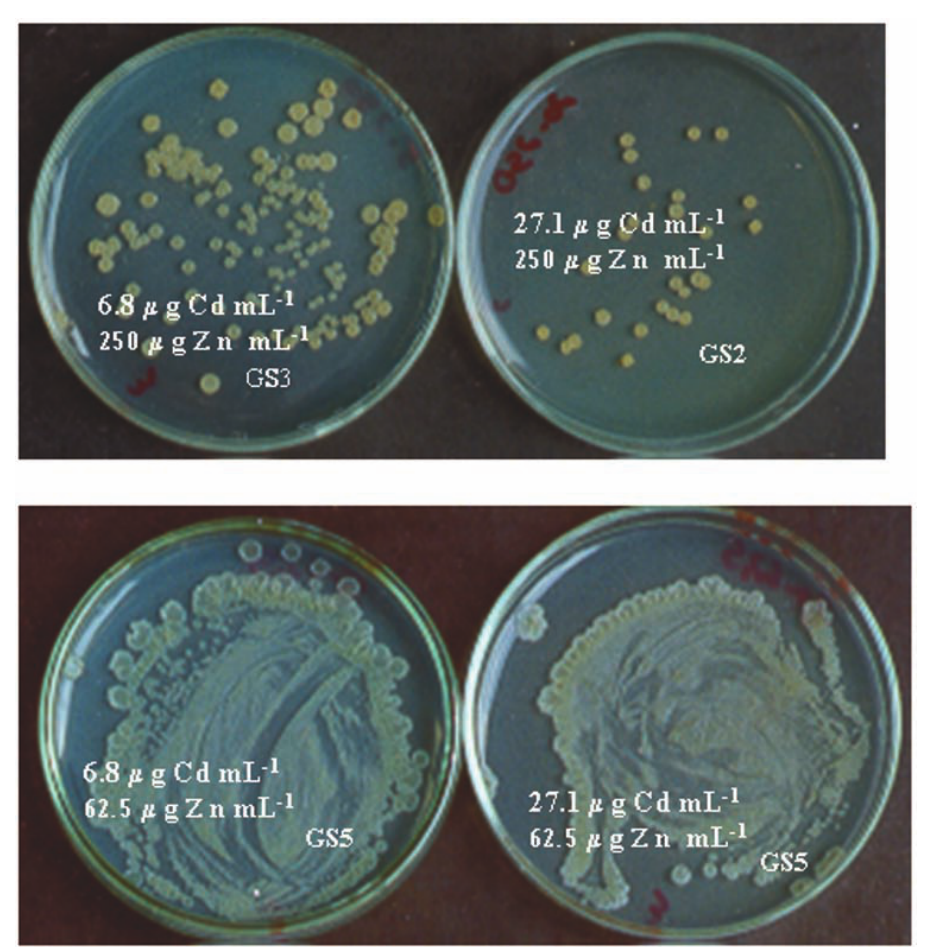
Fig. 4 – Growth scores (GS) of UFLA S34 at different combinations of Zn +2 and Cd +2 concentrations supplemented in dextrose agar medium. Figure shows colony color changing from white to yellow as well as growth decreasing with increasing concentrations of heavy metals. All plates received the some numbers of cells as inoculum. 2 = low growth, 3 = intermediate growth, 5 = very abundant growth as compared to the growth of the isolate in the same medium without heavy metal